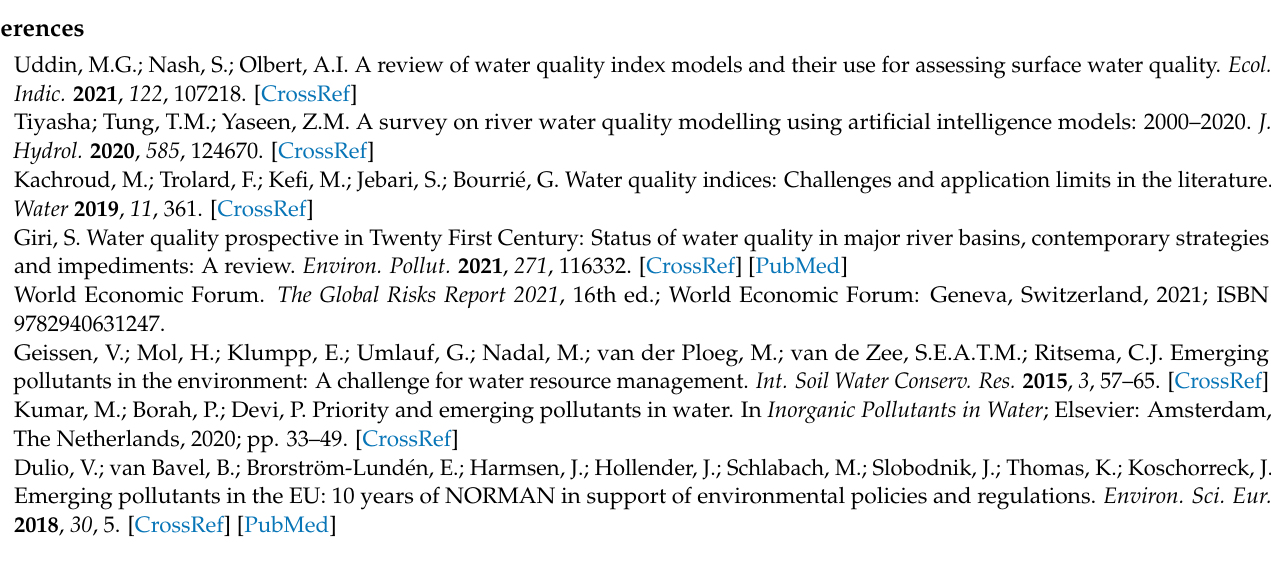
Table S3: Spearman correlation of physicochemical and microbiological parameters of water and sediment samples from the Meia Ponte River; Table S4: Loading matrix showing the main components of the physicochemical and microbiological dataset of water and sediment samples from the Meia Ponte River; Table S5: Percentage of sensitivity and resistance of bacterial isolates bioprospected from the Jo ã o Leite stream, categorized by rainy season; Table S6: Percentage of sensitivity and resistance of bacterial isolates bioprospected from the Jo ã o Leite stream, categorized by dry period; Table S7: Percentage of sensitivity and resistance of bacterial isolates bioprospected from the Jo ã o Leite stream, total; Table S8: Loading matrix showing the main components of the Gram-positive rod/bacillus and Staphylococcaceae resistance and susceptibility dataset isolated from the Meia Ponte River sediment and water samples; Table S9: Loading matrix showing the main components of the resistance and susceptibility dataset of Enterobacteriaceae and Pasteurellaceae isolated from water and sediment samples from the Meia Ponte River; Table S10: Spearman correlation of the resistance and susceptibility dataset of Gram-positive rod/bacillus and Staphylococcaceae isolated from water and sediment samples from the Meia Ponte River; Table S11: Spearman correlation of the resistance and susceptibility dataset from the resistance and susceptibility dataset of Enterobacteriaceae and Pasteurellaceae isolated from water and sediment samples from the Meia Ponte